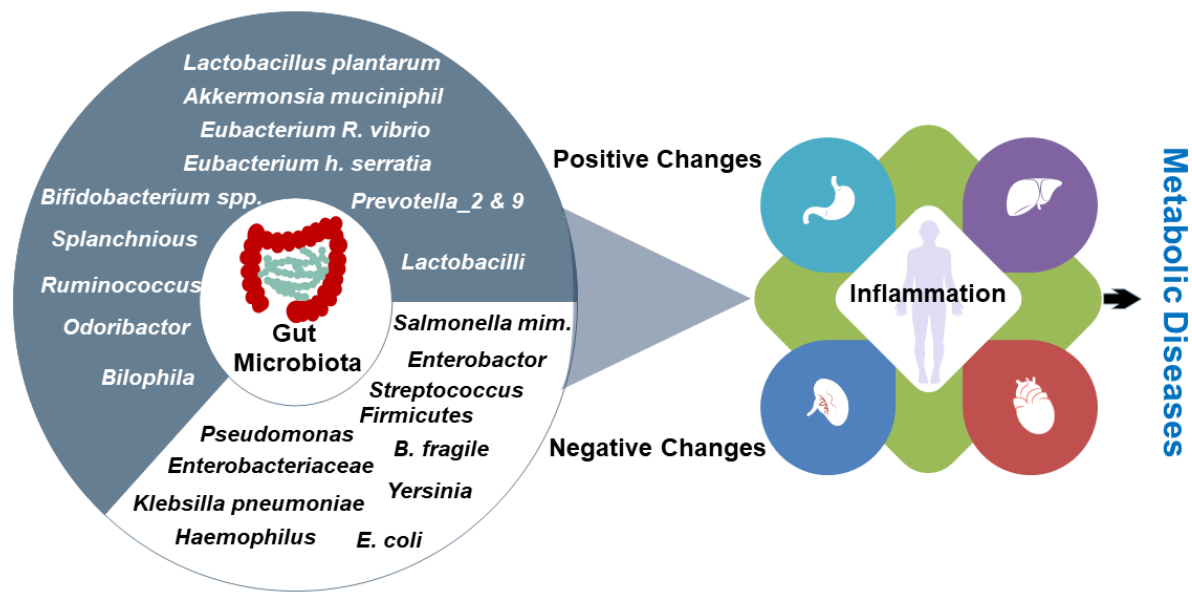
Figure 1. Inflammation-targeted gut